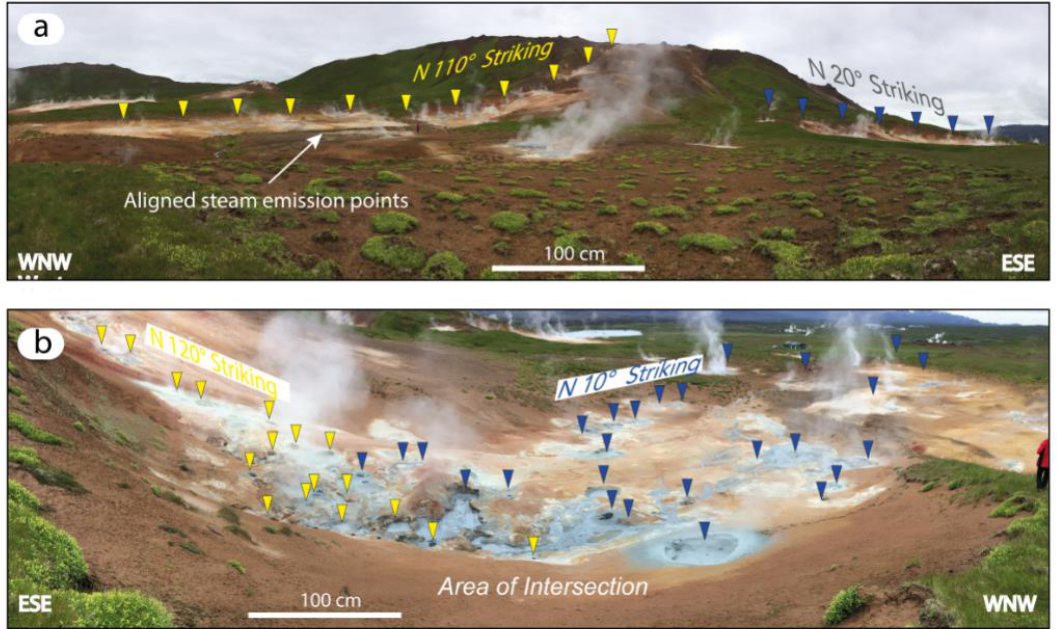
Figure 18. Examples of intersections between the two regional systems of Iceland ( a ) panoramic view of the steam emission points and relationships between the two main indicated trends; ( b ) geothermal manifestation at the intersection area between the two indicated fault trends; after Reference [86].